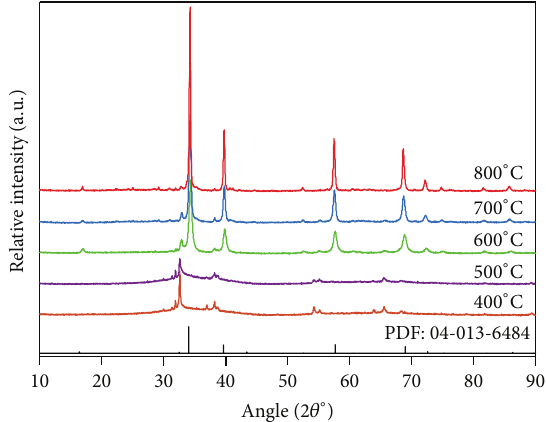
Figure 6: XRD patterns of powder samples prepared at various temperatures (the bottom pattern is the cubic BZT with PDF card